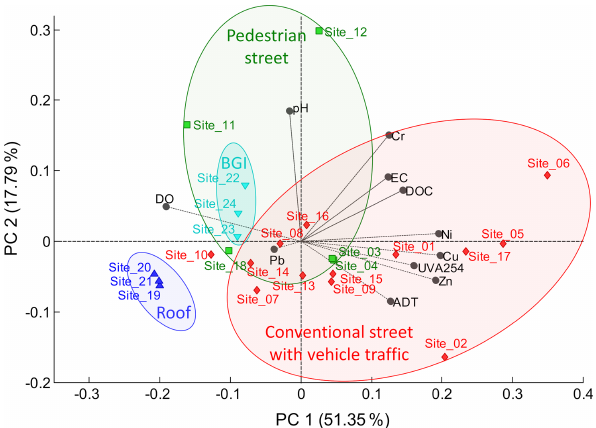
Figure 2. Biplot of the loadings and scores in the principal compo- nent (PC) space. The dominant (PC1) and secondary (PC2) modes are displayed on the x - and y -axis, respectively. Samples are shown in different classes: conventional street with vehicular traffic (red diamonds), pedestrian street (green squares), roof (dark blue trian- gles) and blue-green infrastructure effluent (light blue inverted tri- angle). Classes have been clustered using ellipses with for